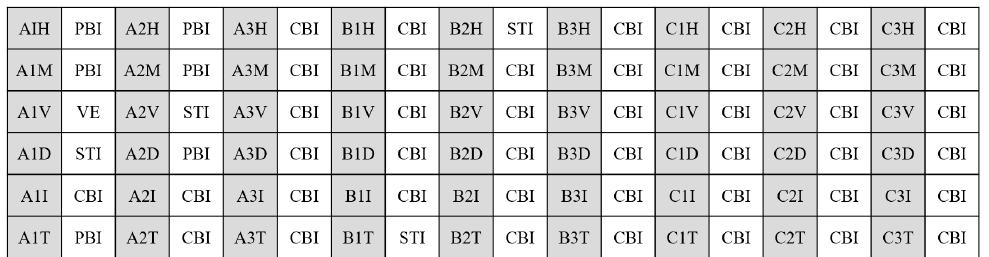
Figure 4. Classification table of extraction difficulty according to the combination of impaction patterns. The column of the gray color represents the combination of impaction patterns and the column of the white color represents the extraction difficulty. The characteristics of the gray column are a combination of the depth of impacted: Class A,B,C and the distance between the third molar and the ascending mandibular ramus: Class I, II, III and the angle of the impacted mandibular third molar: vertical, mesioangular, horizontal, distoangular, transverse